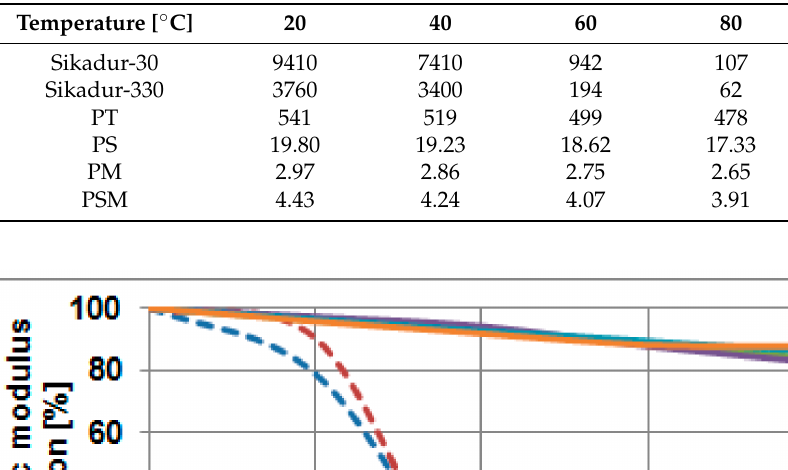
Table 4. The tensile elastic modulus (MPa) of the adhesives in a 20–100 ◦ C range [28].